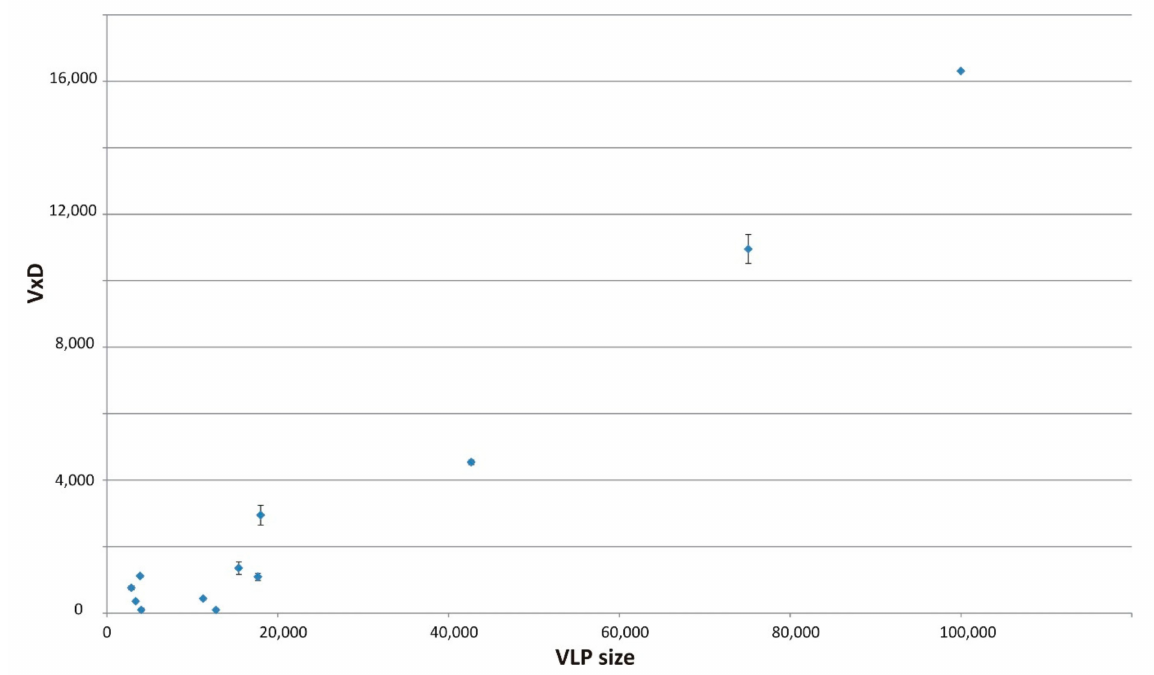
Figure 22. Graph reporting the VLP size vs. the volcanology parameters (V × D) obtained multiplying the muzzle velocity (V, in m s − 1 ) of each event by the duration (D, in s). See Table 4 for the list of